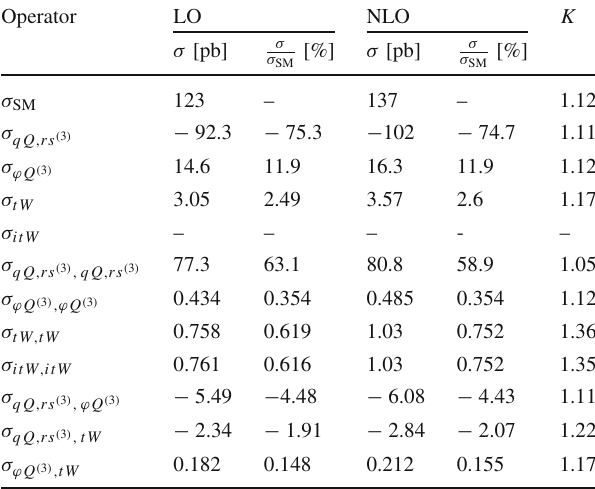
Table 1 Contributions to the cross section in pb for t -channel single top production at 13 TeV, as parameterised in Eq. (3.3). These values have been extracted from fitting Eq. (3.3), to a hundred computed cross sectionswithrandomlychosencouplingstrengthsfortheeffectiveoper- ators, both for LO and NLO separately. The statistical errors for each contribution in the table is below 1% except for the σ qQij , tW term at NLO,whichisat1.1%.Theright-hand-sidecolumnshowsthe K -factor, which is defined for each row as the ratio of the NLO over the LO pre- diction. By the subscripts tW and itW we denote the contributions of the real and imaginary parts of C tW